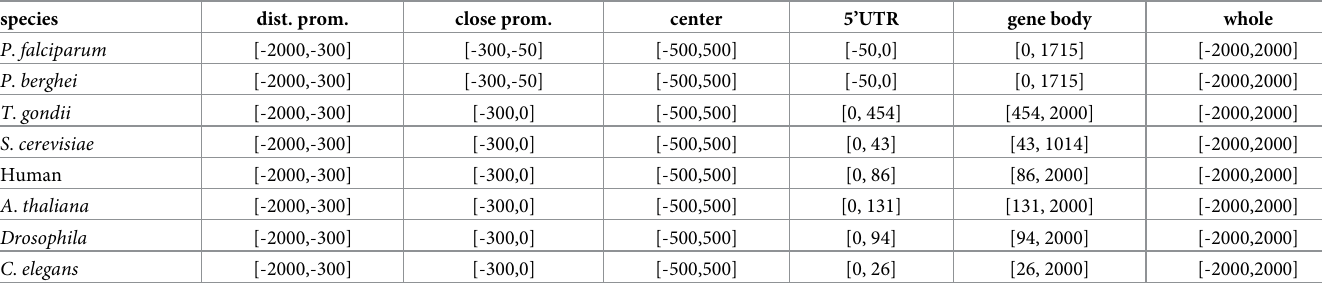
Table 1. Boundaries defining gene regions in the different species. species dist.